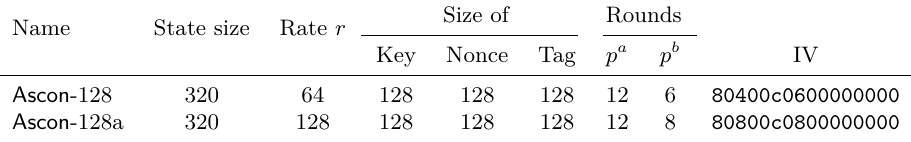
Table 2: Ascon variants and their recommended